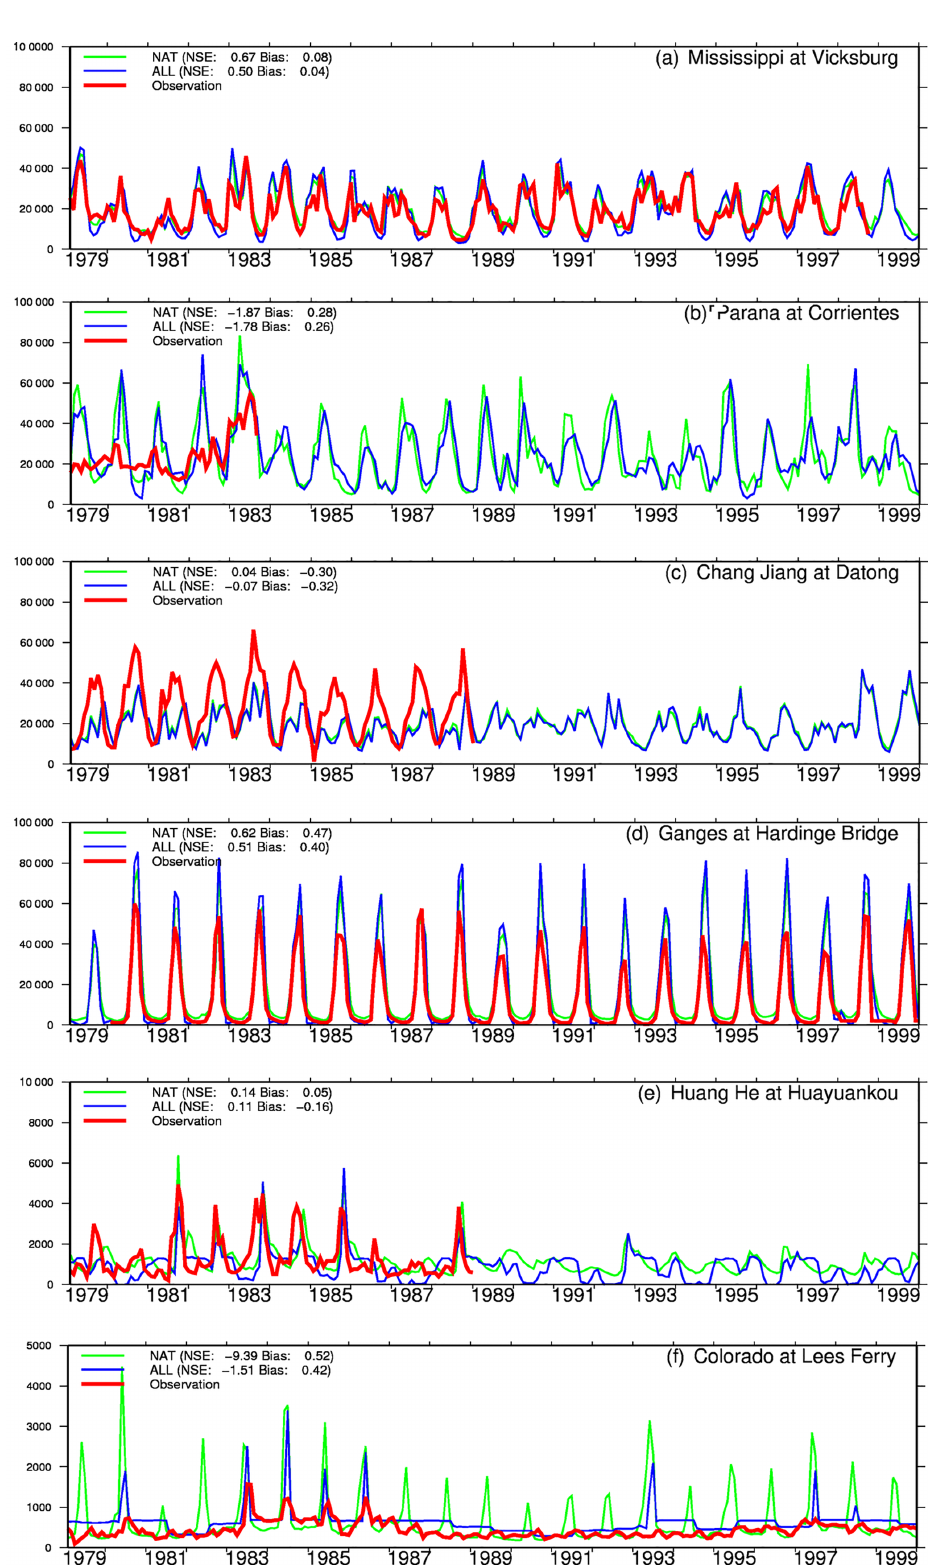
Figure 9. Monthly river discharge of (a) the Mississippi River at Vicksburg, (b) the Parana River at Corrientes, (c) the Chang Jiang River at Datong, (d) the Ganges River at Hardinge Bridge, (e) the Huang He River at Huayuankou, and (f) the Colorado River at Lees